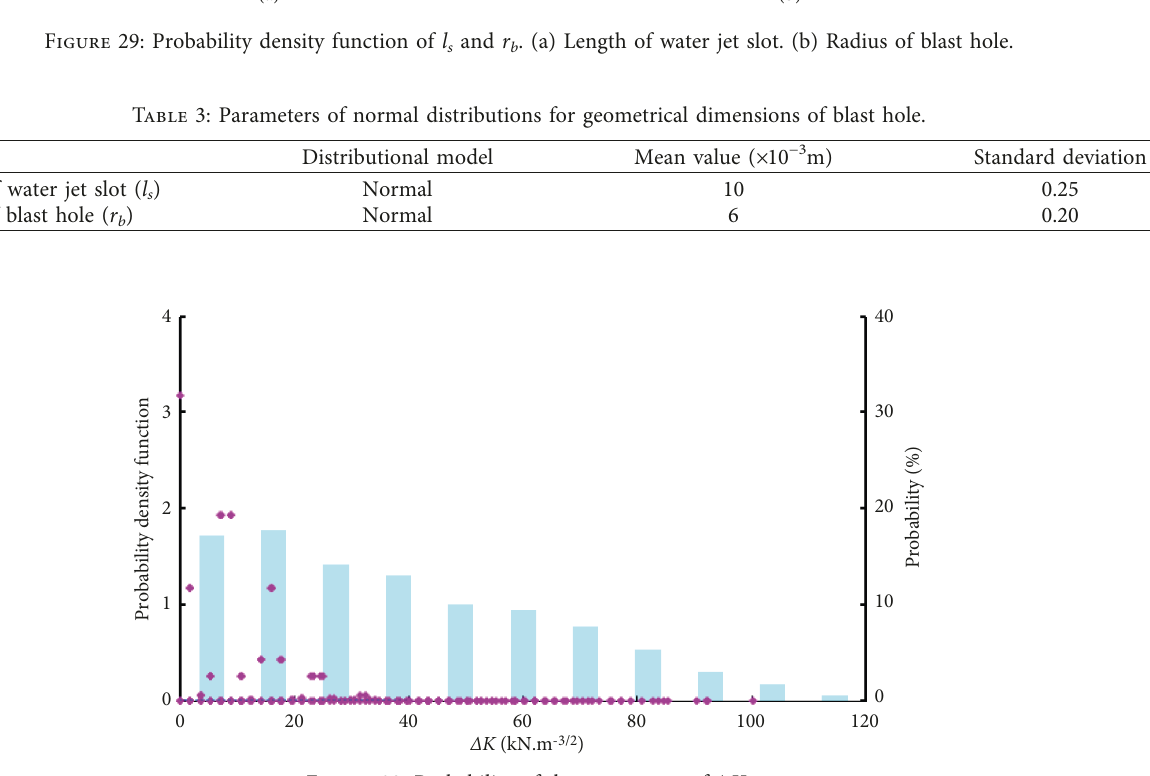
Figure 30: Probability of the occurrence of Δ K